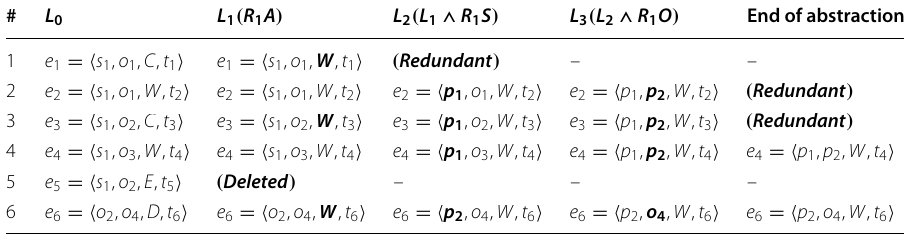
Table 10 An example of events abstraction